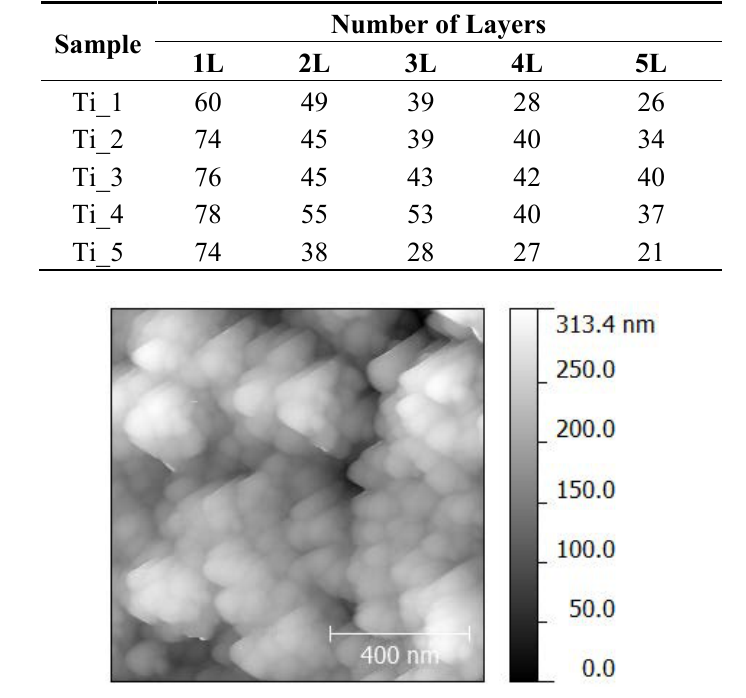
Figure 4. Topography of the sample